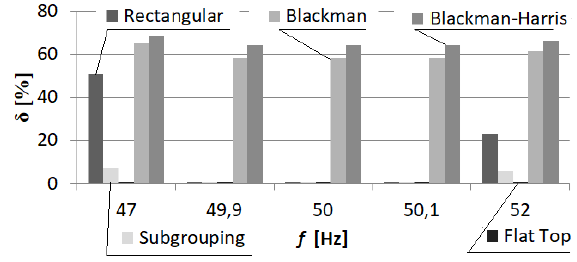
Fig. 2. Distribution of relative error of the fundamental harmonic for the sinusoidal test signal.